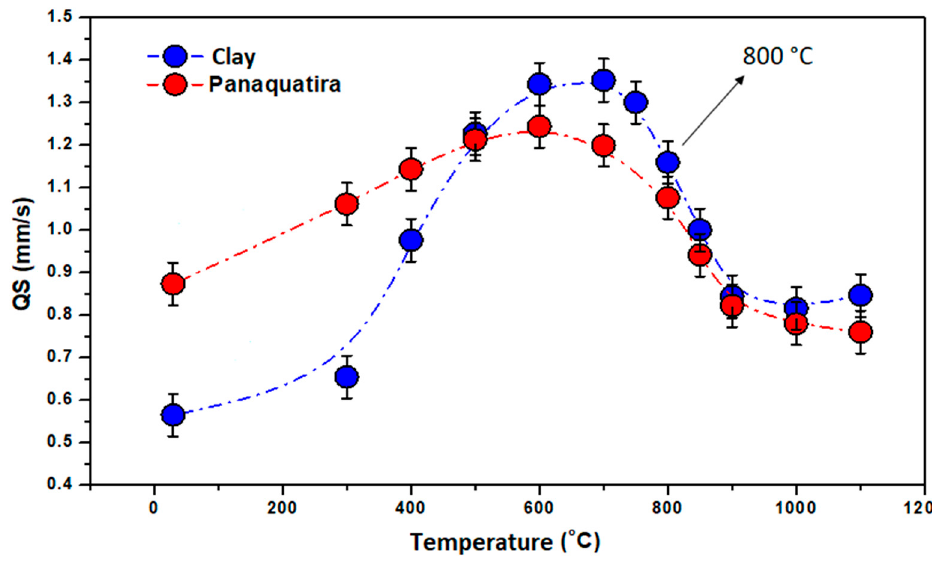
Figure 8. Clay calibration curve and Panaquatira 0–5 cm sample data comparison.